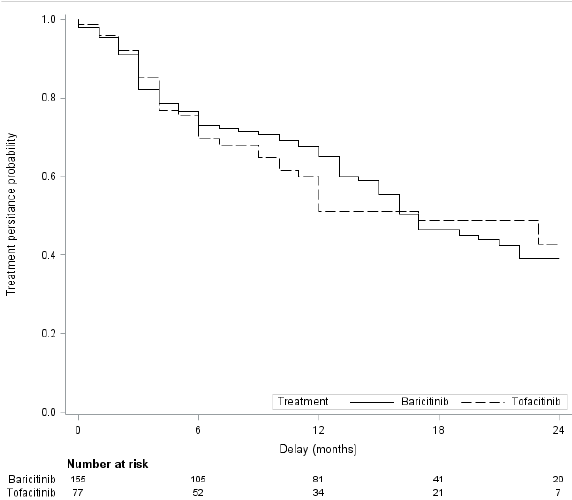
Figure 1. Two-year follow-up treatment persistence with Baricitinib and Tofacitinib.